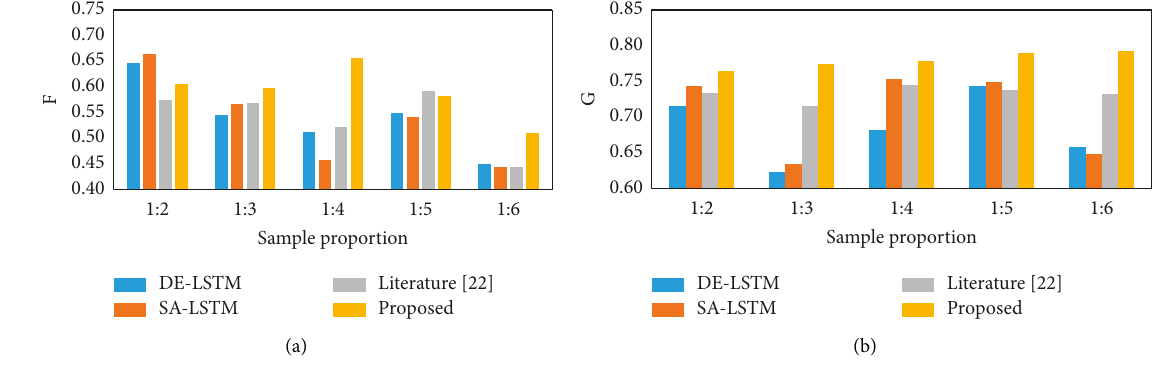
Figure 9: Comparison of prediction results of four types of models with different sample